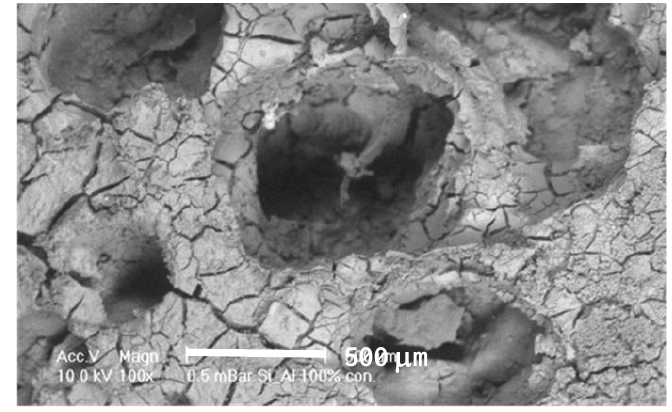
Figure 4. SEM of porous alumina with 100% Si.